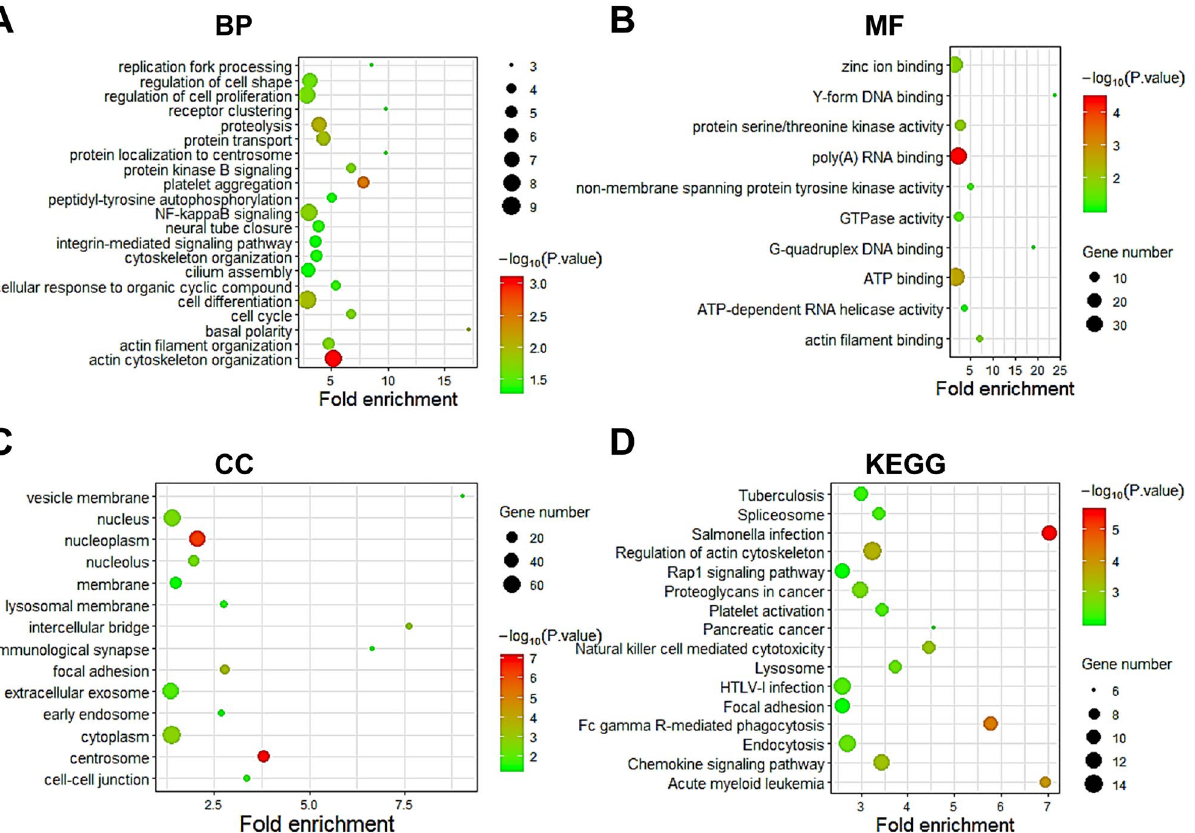
to the function of